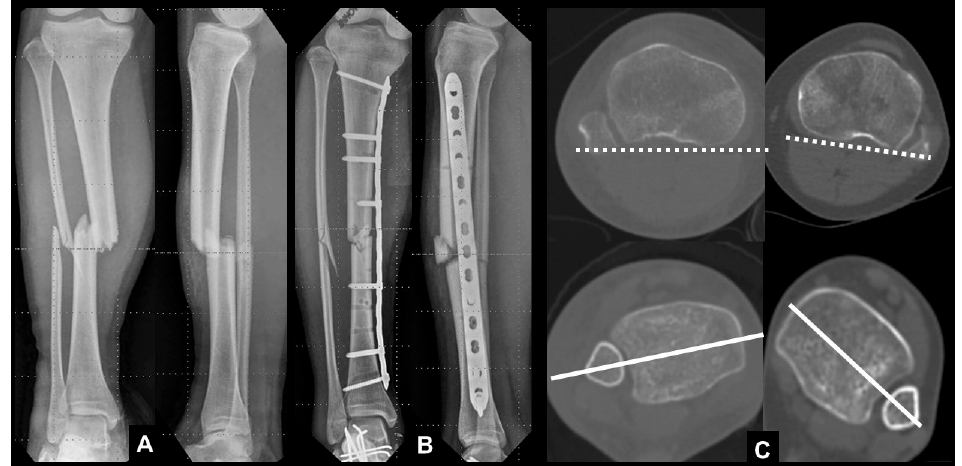
Figure 7. ( A ) A 15-year-old girl with a tibia shaft fracture; ( B ) minimally invasive plate osteosynthesis